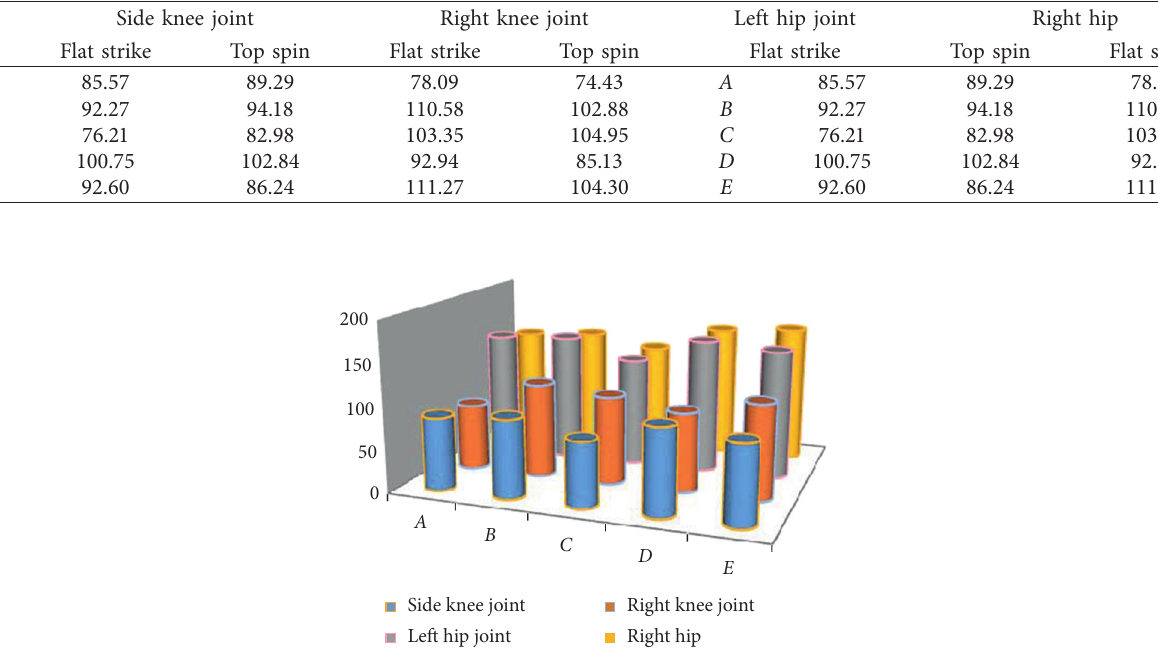
Figure 8: Comparison of the smallest angles of the knee and hip joints at the racket stage of the flat strike.